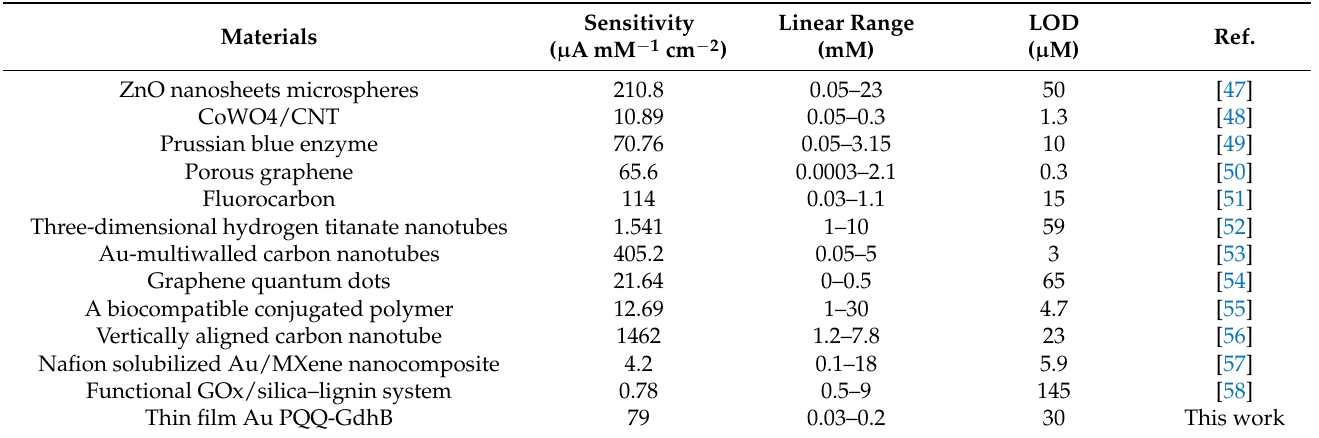
Table 1. Performance comparison of proposed biosensor with existing glucose electrochemical